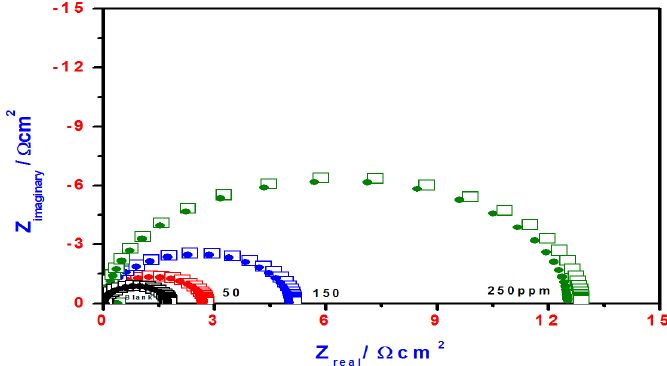
Figure 6. The influence of T3AMPy concentrations on the the Nyquist plots of steel in acidic chloride solution. Molecules 2016 , 21 , 436 6 of 11